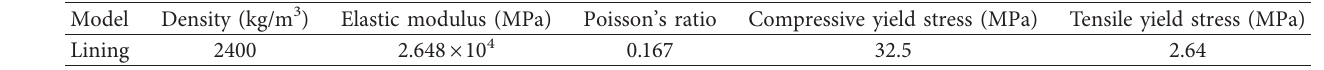
Figure 1: Schematic diagram of the calculation model for dip angle 45 ° . Table 1: Material parameters of tunnel lining.